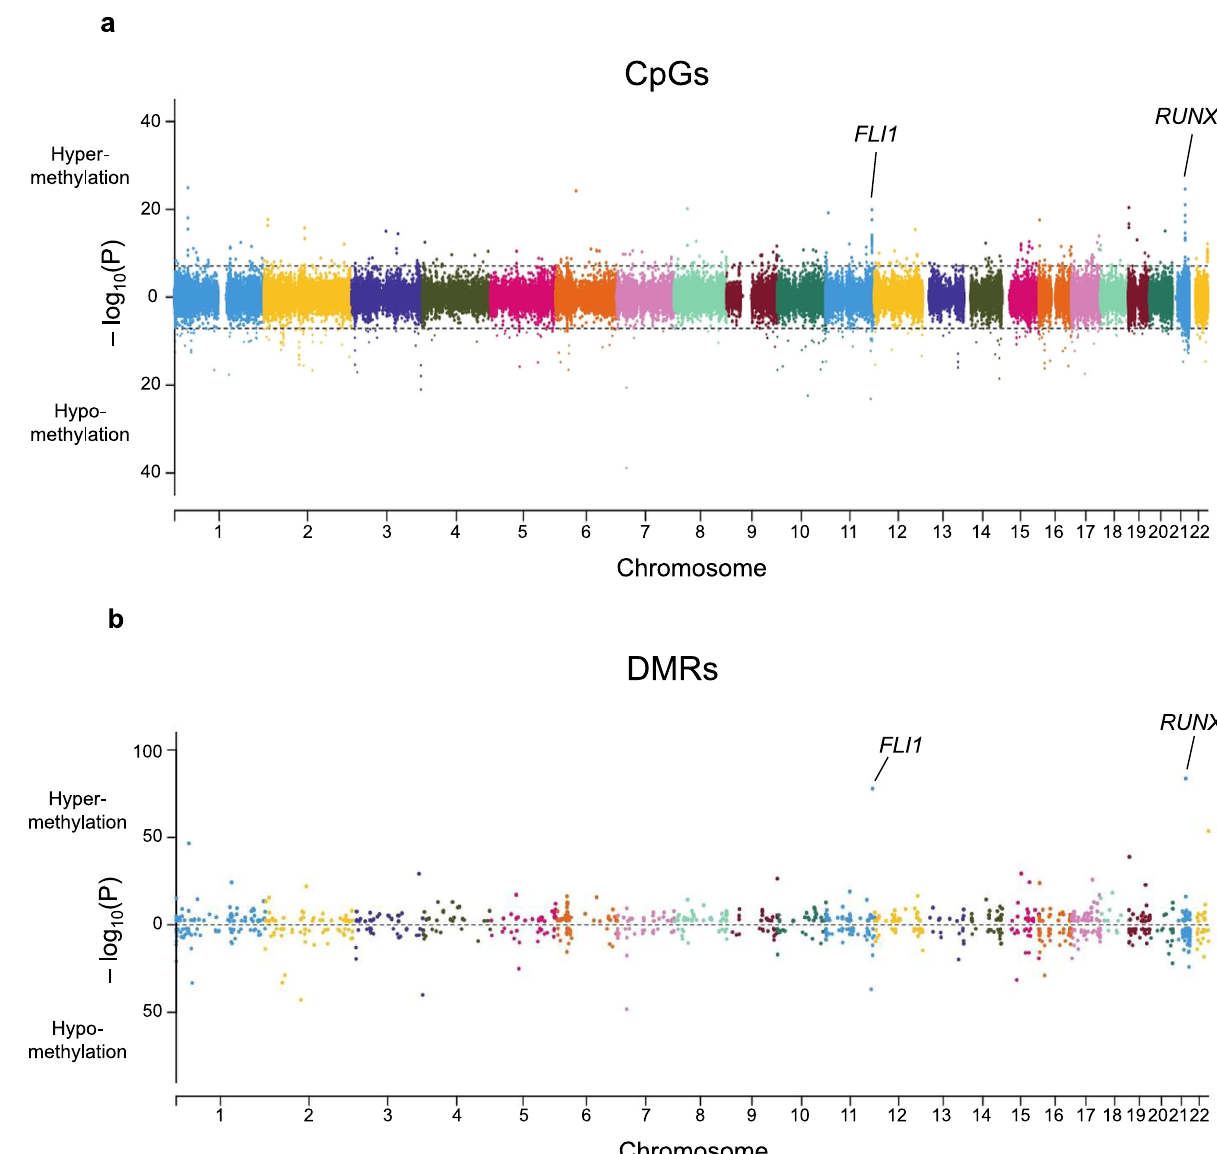
Fig. 3 Bidirectional Manhattan plots displaying Down syndrome (DS)-associated CpGs and differentially methylated regions (DMRs) genome-wide. a Manhattan plot presenting the − log 10 ( P ) values of autosomal CpGs derived from the multiethnic epigenome-wide association study (EWAS) of DS. P values were calculated using linear regression testing the association of each CpG beta-value with DS, adjusting for sex, plate, the fi rst ten ReFACToR principal components (PCs), and the fi rst ten EPISTRUCTURE PCs. Points above zero correspond to CpGs that were hypermethylated in DS ( N = 196) versus non-DS ( N = 439) newborns, whereas points below zero correspond to hypomethylated CpGs in DS. The genomic in fl ation factor ( λ ) was 1.47. Dotted lines correspond to the threshold for epigenome-wide signi fi cance ( P = 7.67×10 − 8 ) after Bonferroni correction for multiple testing. The strong association peaks at FLI1 on chromosome 11 and RUNX1 on chromosome 21 are highlighted. b Manhattan plot showing DMRs identi fi ed in the overall multiethnic analysis using DMRcate and comb-p. The – log 10 ( P ) values were derived from the Š idák-corrected P values from the more stringent method, comb-p, with the DS EWAS P values at each CpG as input. Points above zero correspond to DMRs with a mean Δ β - value above 0 (hypermethylated in DS), whereas points below zero correspond to hypomethylated DMRs in DS. The top two signi fi cant DMRs in RUNX1 and FLI1 are highlighted. We identi fi ed DMRs in several additional genes that regulate hematopoiesis and/or are known drivers of leukemogenesis, including at Hsa21 genes DYRK1A (DMR N = 3), ERG ( N = 2), and ETS2 ( N = 1), and at non-Hsa21 genes ETV6 ( N = 3), BCR and KIT (both N = 2), and GATA2 , TET1 , TET2 , FLT3 , DNMT3A , KAT6B , KMT2C , PBX1 , and RARA (all N = 1) (Supplementary Data